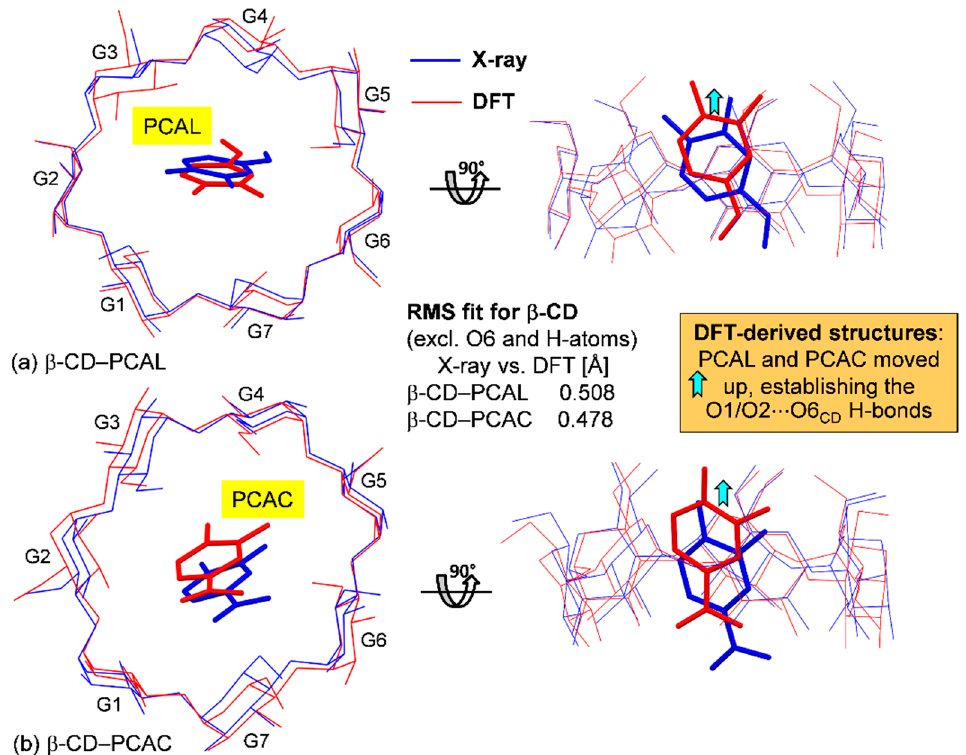
Figure 6. Structural comparison of the inclusion complexes ( a ) β -CD–PCAL and ( b ) β -CD–PCAC from X-ray analysis (blue lines) and DFT calculation in the gas phase (red lines); see also Figure 7, Figure S1 and Tables S5 and S6. The rms fits are calculated for the non-H atoms using the X-ray-derived β -CD skeleton as a reference structure (excluding O6 atoms). Note that after DFT full-geometry optimization, PCAL and PCAC molecules are shifted up to form O1/O2···O6 H-bonds with β -CD O6–H perimeter (Table 2).